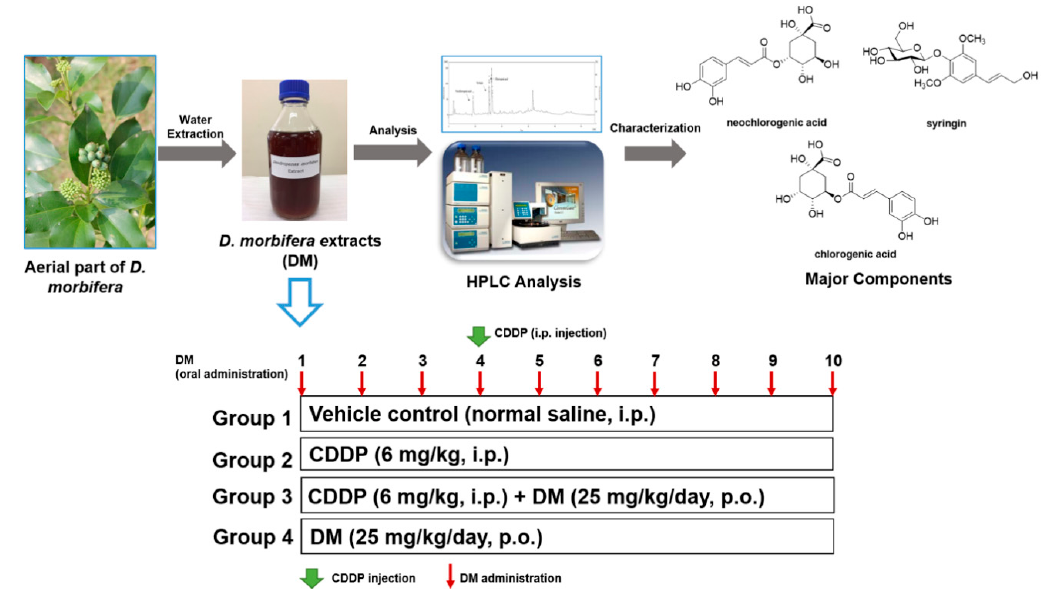
Figure 1. Preparation of Dendropanax morbifera water extract (DM) and experimental design of cisplatin (CDDP)-induced nephrotoxicity in rats. Rats were randomly divided into four groups: The control group, which received normal saline; the CDDP (6 mg/kg, single intraperitoneal (i.p.) injection) group; the CDDP (6 mg/kg, single i.p. injection) + DM (25 mg/kg/day) group; and the DM (25 mg/kg/day) group. The DM was administered orally for 10 days.